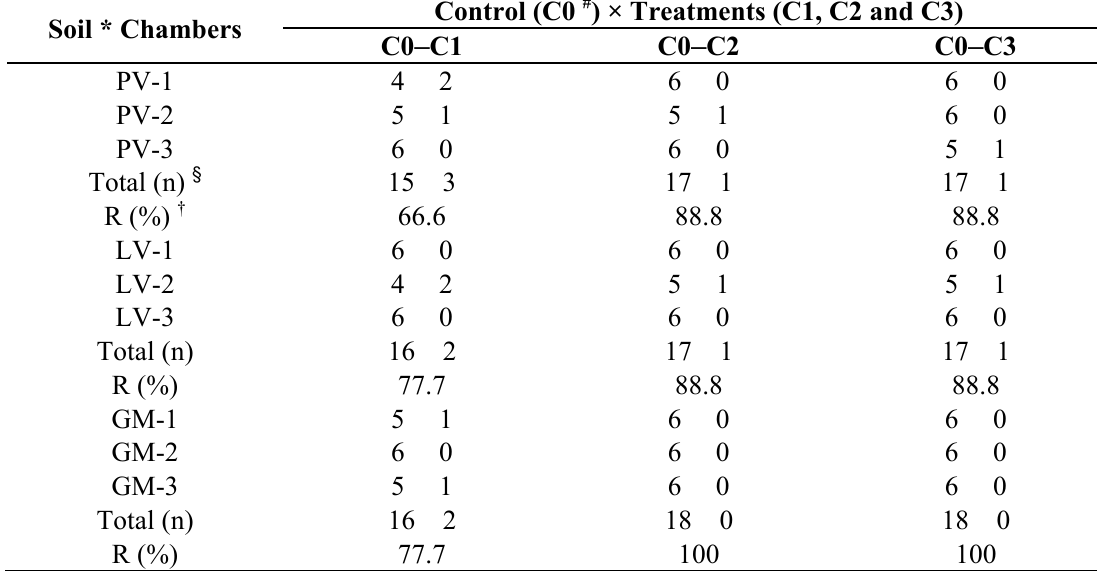
Table 2. Avoidance of the earthworms Eisenia andrei to three different agricultural soils treated with different concentrations of technical grade cypermethrin.